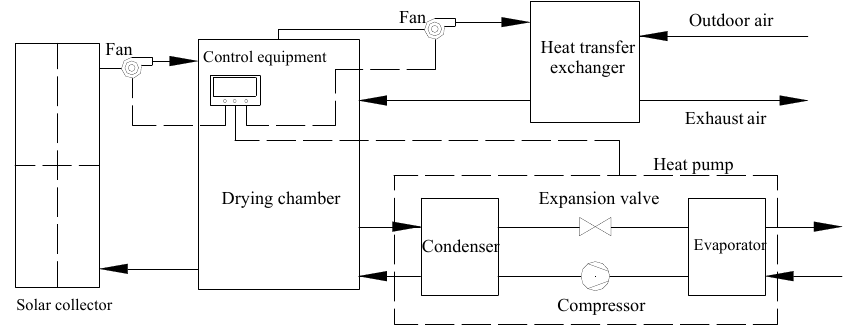
Figure 4. Working principle of the solar assisted heat pump (SAHP) drying system.